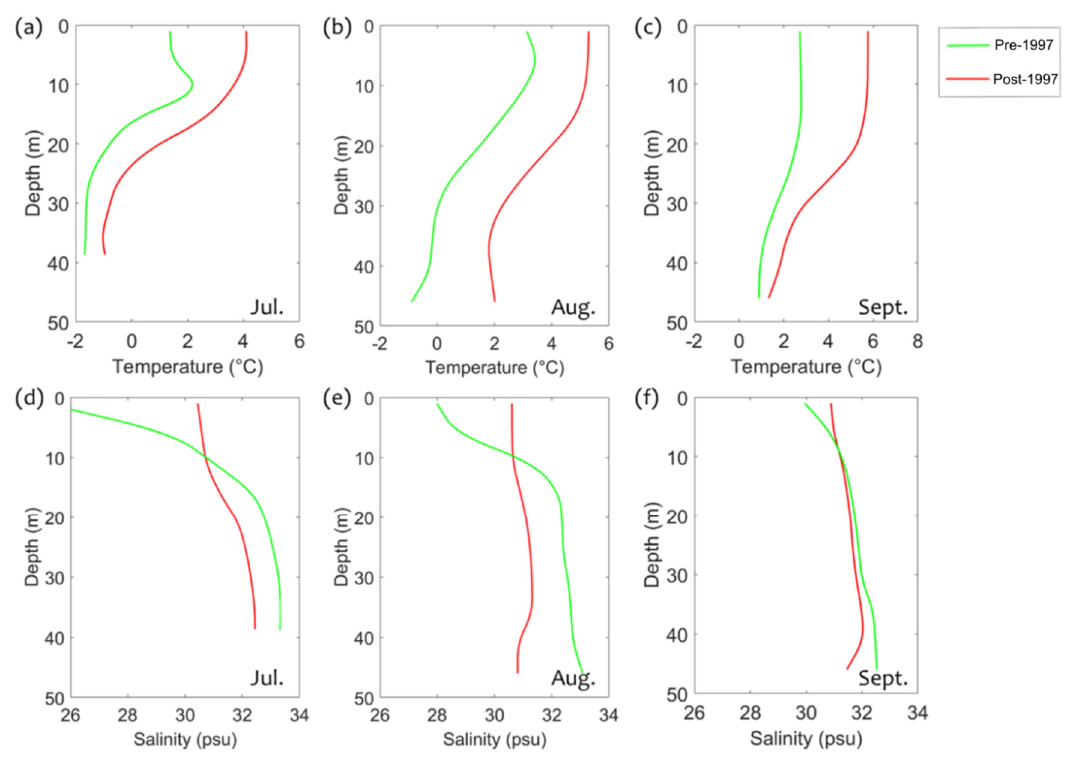
Figure 14. The regional average ( a – c ) T and ( d – f ) S profiles of the central Chukchi shelf from Figure 14. As Figure 13, but for central Chukchi shelf. July to September. The green and red lines represent the average values of the pre- and post-1997 Water 2020 , 12 , x FOR PEER REVIEW periods, respectively.